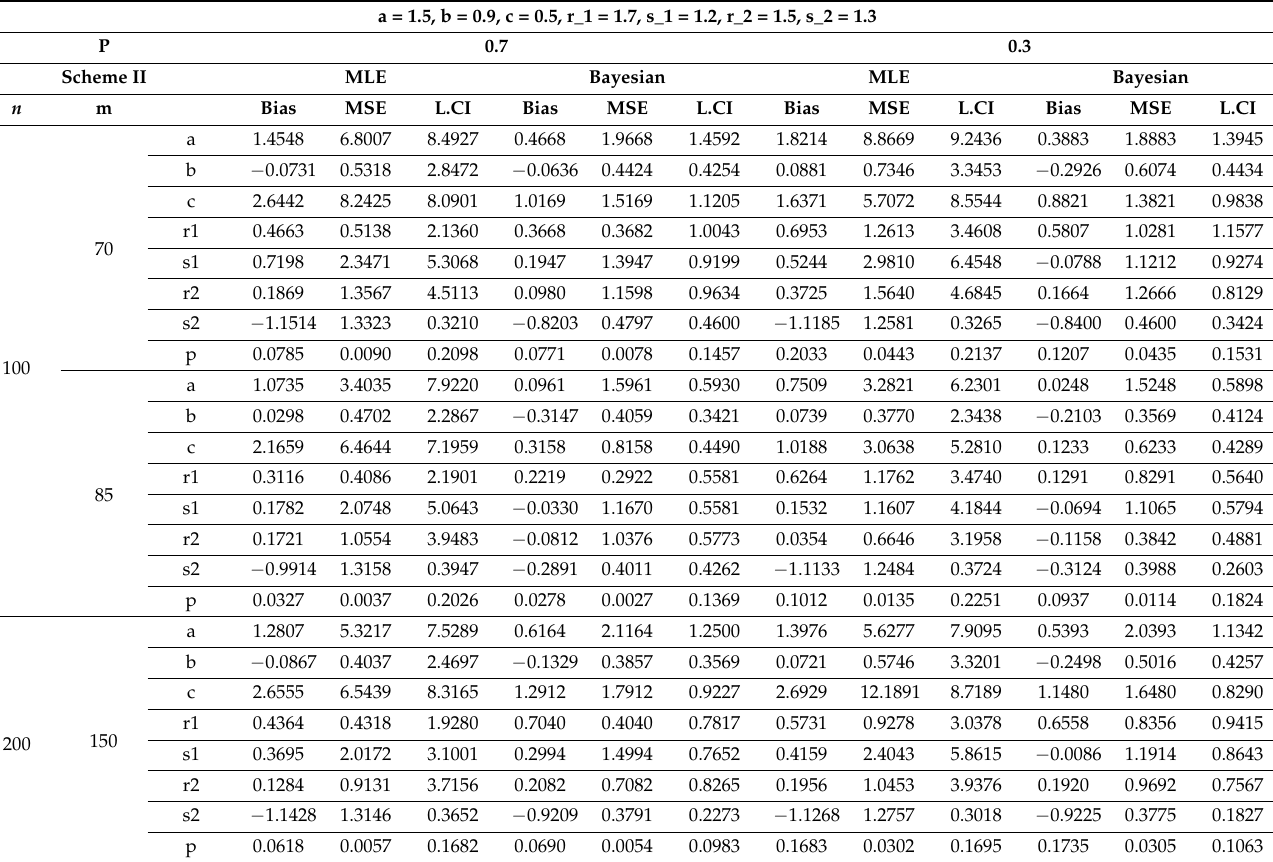
Table 1. MLE and the Bayesian estimates for eight parameters of MEKGEKF model based on a progressively Type II censoring scheme: scheme